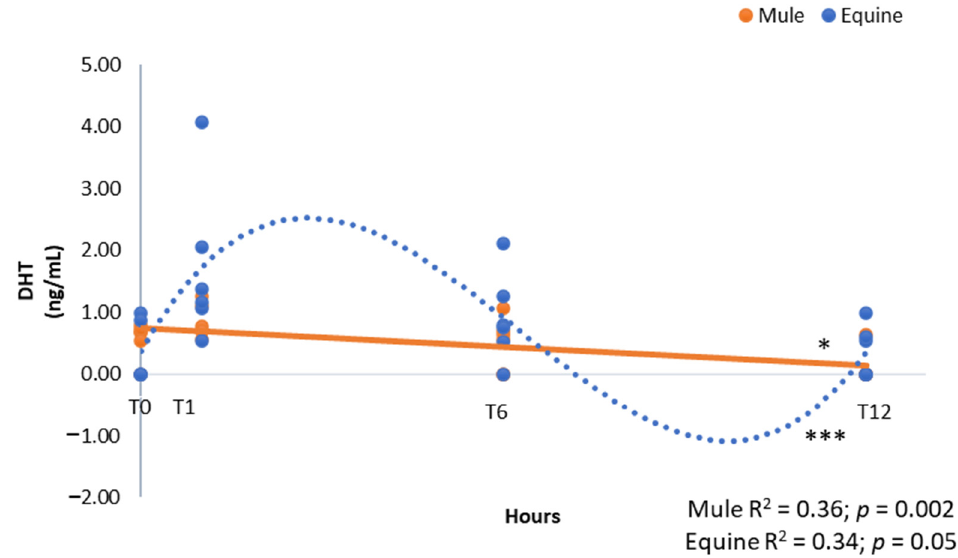
Figure 1. Androgen concentrations of dihydrotestosterone (DHT, ng/mL) in neonatal mule ( n = 6, solid line) and equine ( n = 6, dashed line) foals at birth (immediately after expulsion–T0), and at 1 (T1), 6 (T6) and 12 h after birth (T12). Results represent the mean. * Linear and *** cubic effects are shown with R2 and p -values.